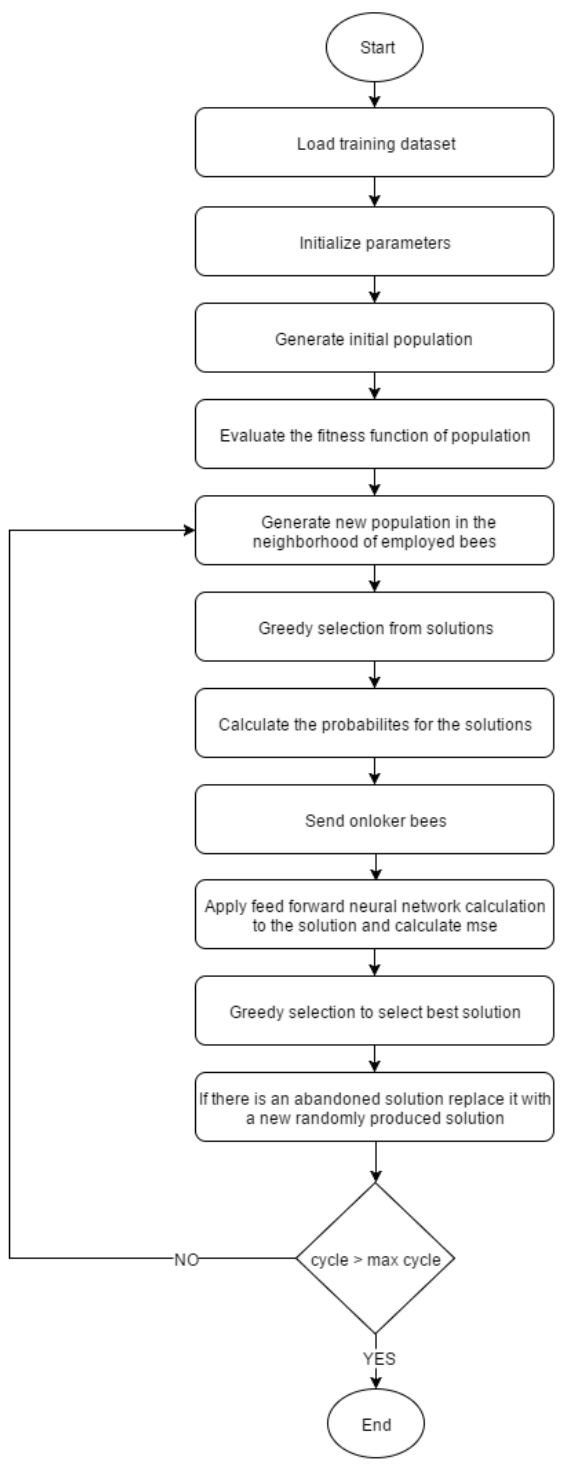
Figure 4. Flowchart of ABC-based